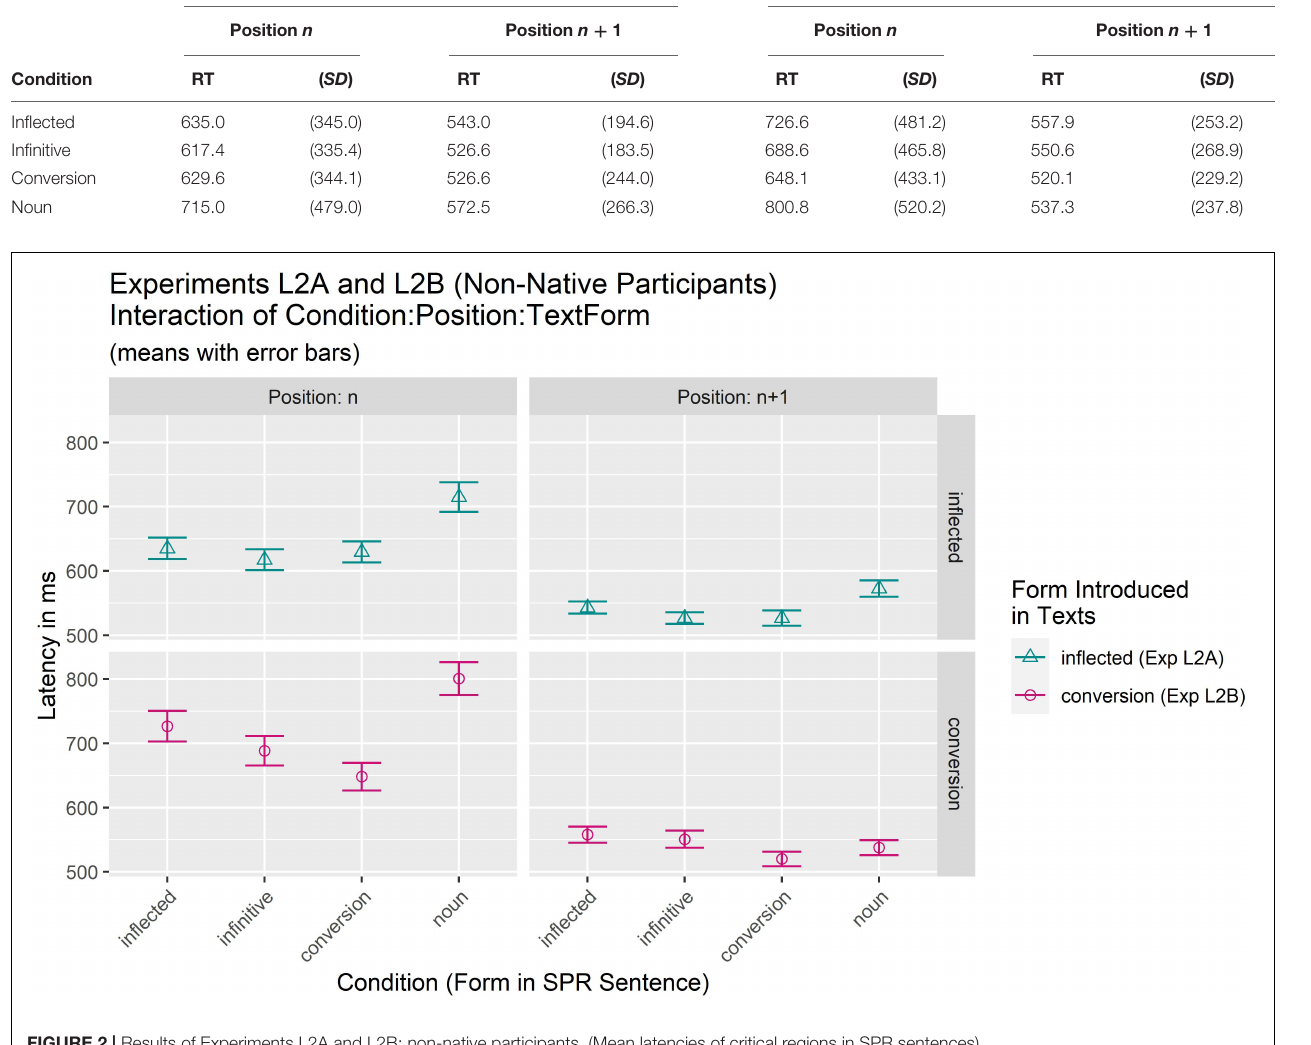
FIGURE 2 | Results of Experiments L2A and L2B: non-native participants. (Mean latencies of critical regions in SPR